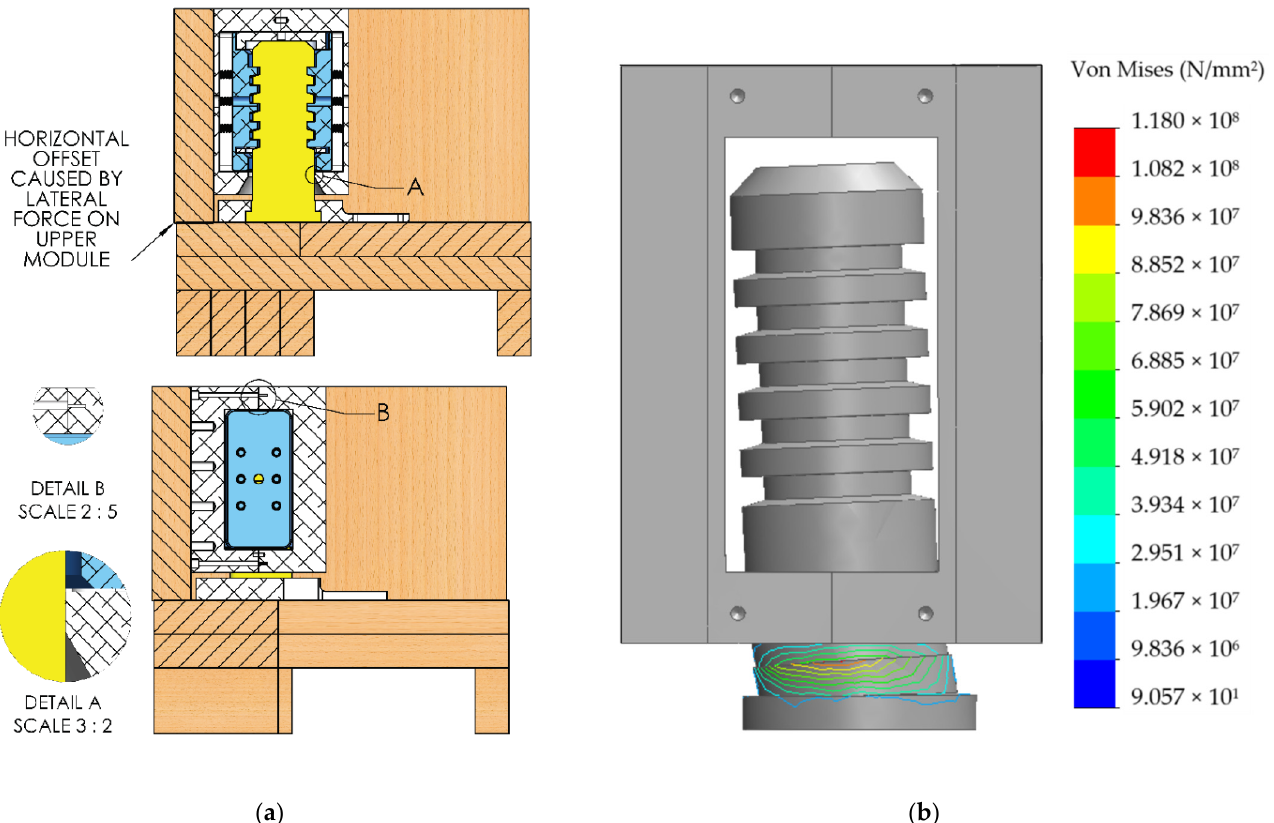
Figure 5. ( a ) 3D model of the physical motion created by shear loading, ( b ) FEA simulated deformation of the shaft caused by shear loading (deformation scale 400:1).